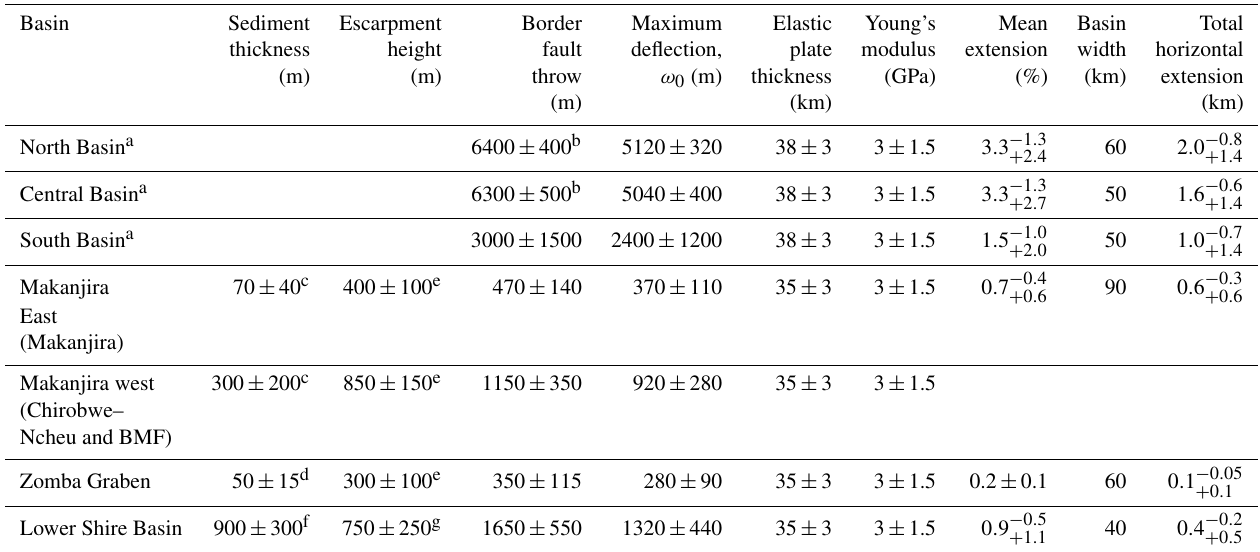
Table A2. Inputs and results of hanging wall flexure analysis across Malawi. ω 0 and maximum hanging wall deflection calculated from Eq.